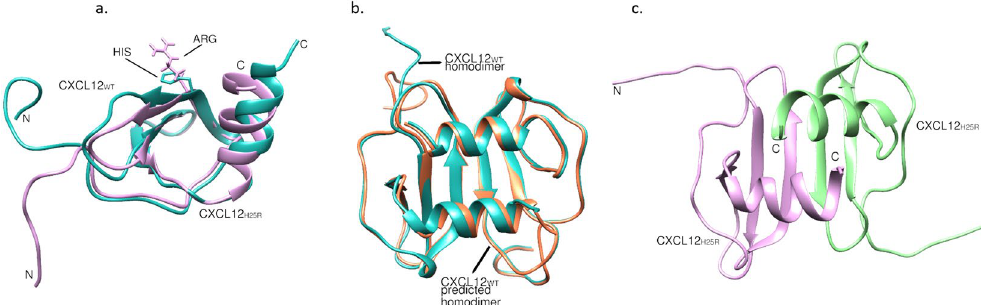
Figure 11. CXCL12 monomer and dimer structures. ( a ) Superposition of CXCL12 WT (PDB ID: 2j7zA) and CXL12 H25R (PDB ID: 2kolA) conformations. The RMSD value of aligned structures is 6.29 Å. ( b ) Superposition of the PRISM prediction for CXCL12 WT homodimer (orange) and the available structure in PDB i.e. 2j7z (blue). ( c ) PRISM prediction for CXCL12 H25R